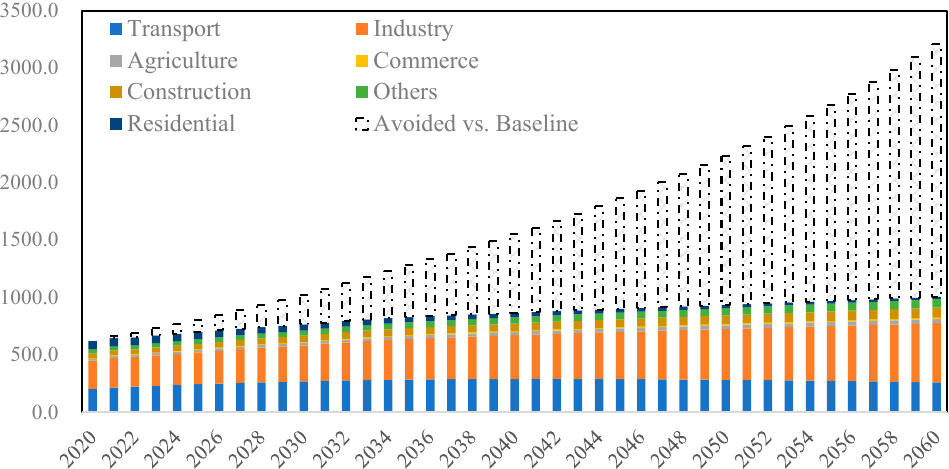
Figure 11. Petroleum products demand under sub-scenario 2 and the changes relative to baseline.